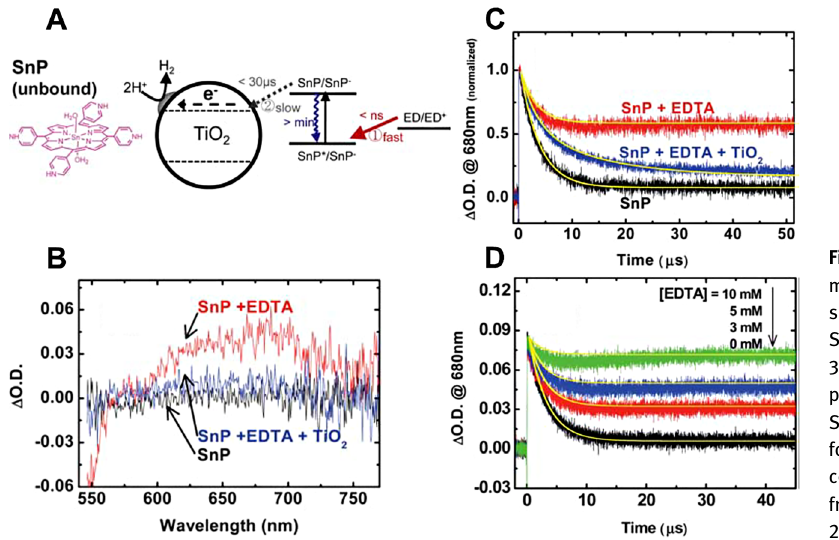
Figure 9: (A) Proposed charge dynamics mechanism of SnP-sensitized TiO 2 . (B) In situ transient absorption (TA) spectra